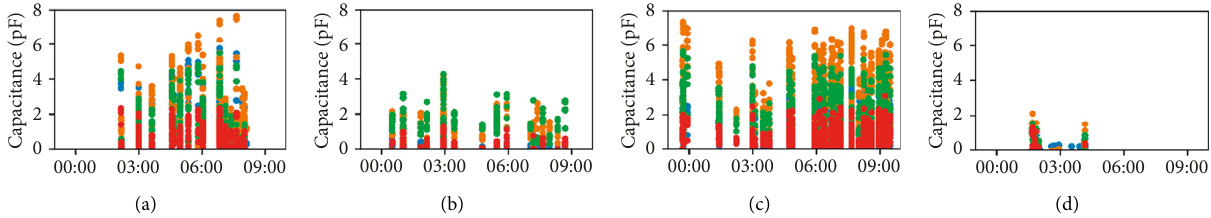
Figure 4: Comparison of a full night of recording for the four test subjects. The 4-coloured dots represent the signal from each of the 4 sensors in the bite. Activity in subjects affected by bruxism (a–c) and a not-affected one (d) is shown.